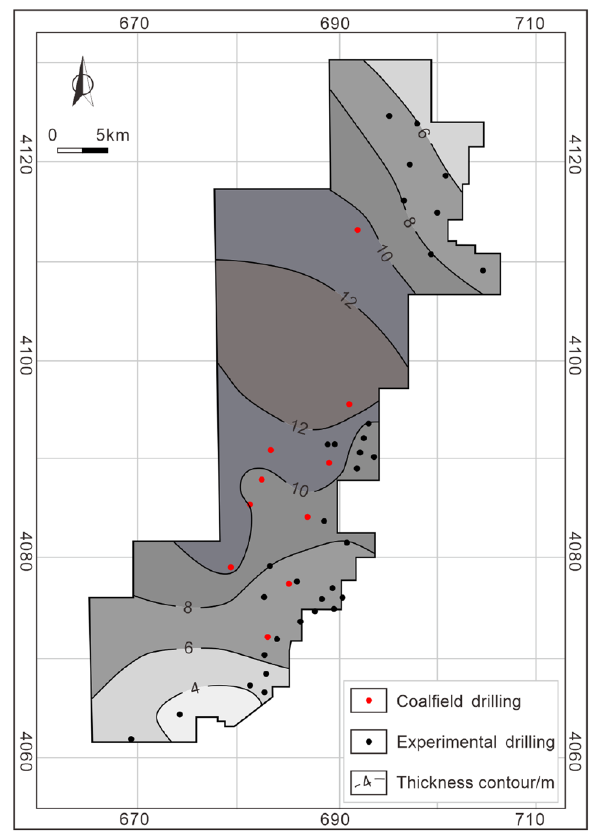
Figure 4. Cumulative thickness contour of coal seams in the Taiyuan